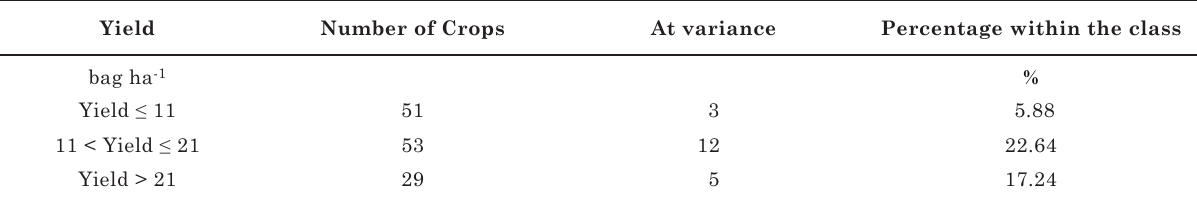
table 3. number of crops per yield class, number of non-coincident crops between the dris and the FRL in the low-yielding coffee group yield number of Crops at variance percentage within the class bag ha